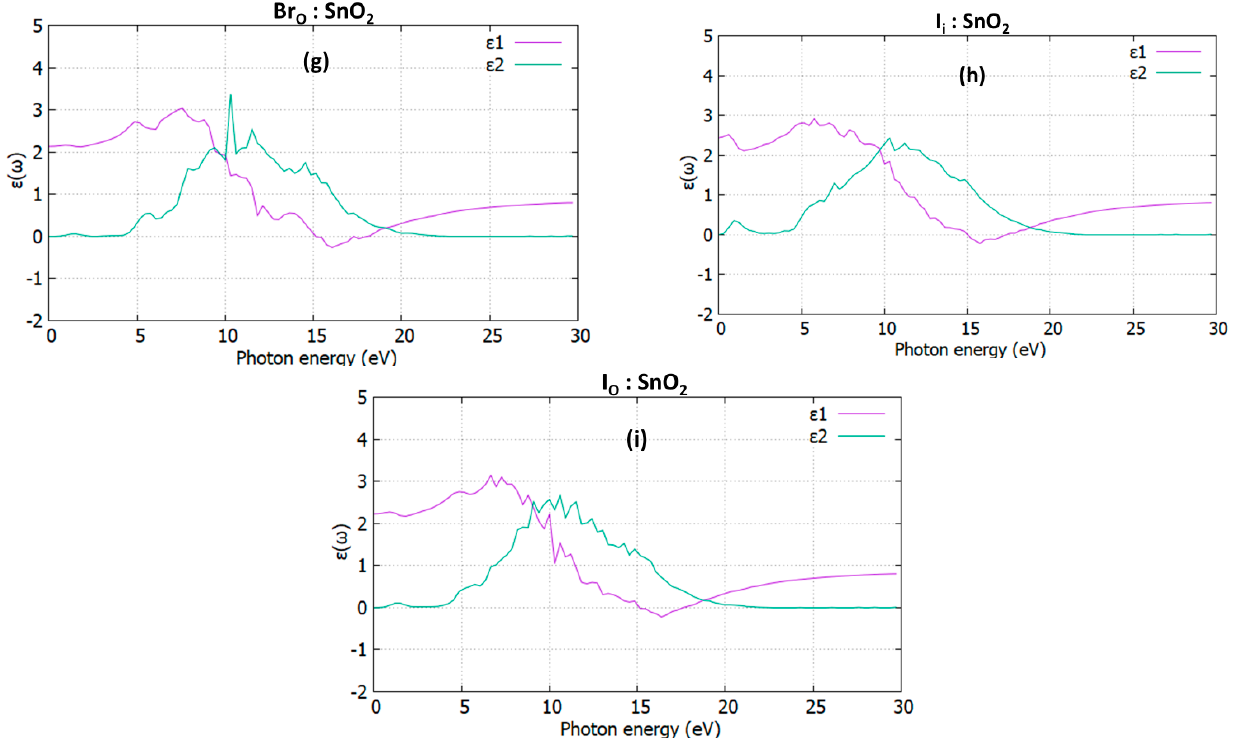
Figure 5. The dielectric function of the ( a ) undoped SnO 2 , ( b ) Fi doped SnO 2 , ( c ) Fo doped SnO 2 , ( d ) Cli doped SnO 2 , ( e ) Clo doped SnO 2 , ( f ) Br i doped SnO 2 , ( g ) Br O doped SnO 2 , ( h ) I i doped SnO 2 , and ( i ) I O doped SnO 2 .